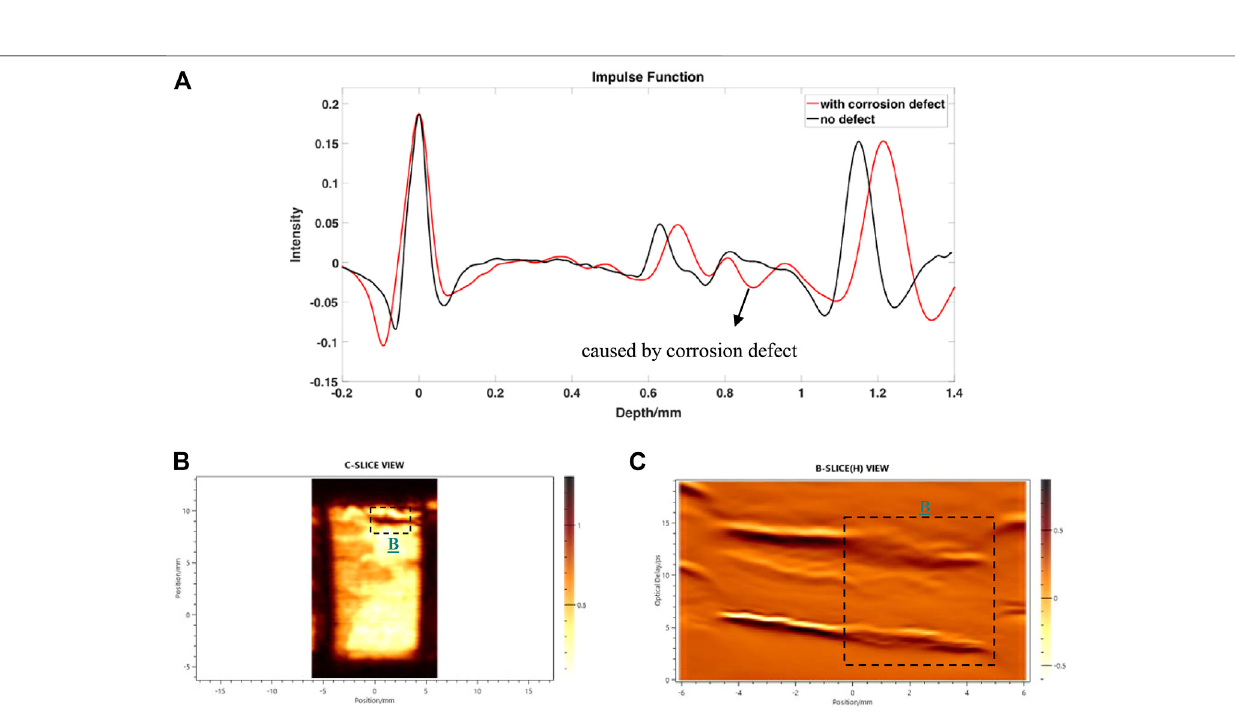
Frontiers in Physics |